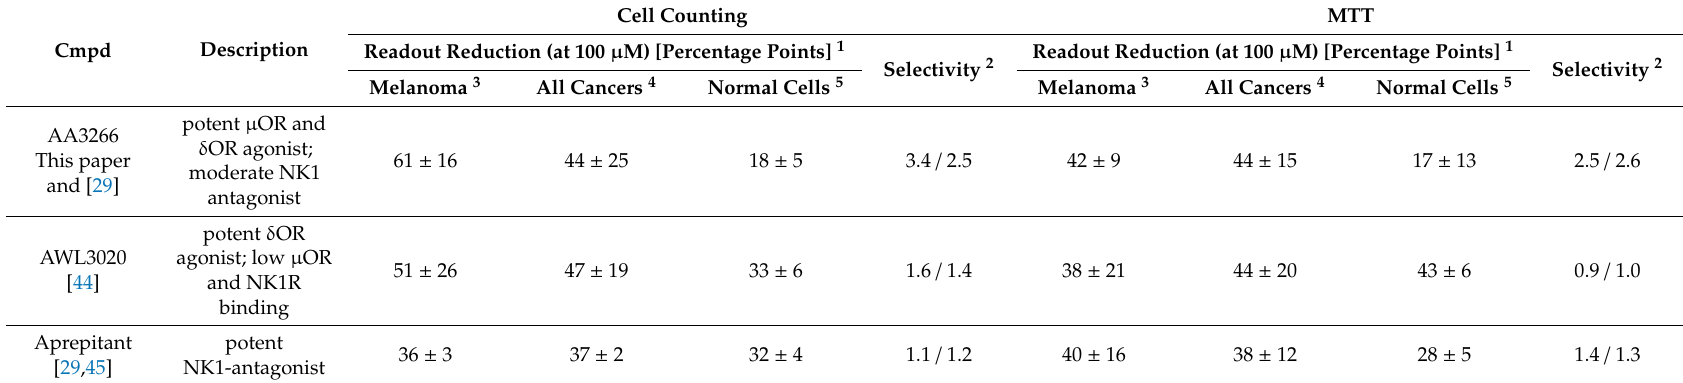
Table 1. Cytotoxic selectivity of AA3266 and reference compounds. Average ( ± S.D.) readout reductions (compared to control) in cell counting and MTT assays, after incubation with 100 µ